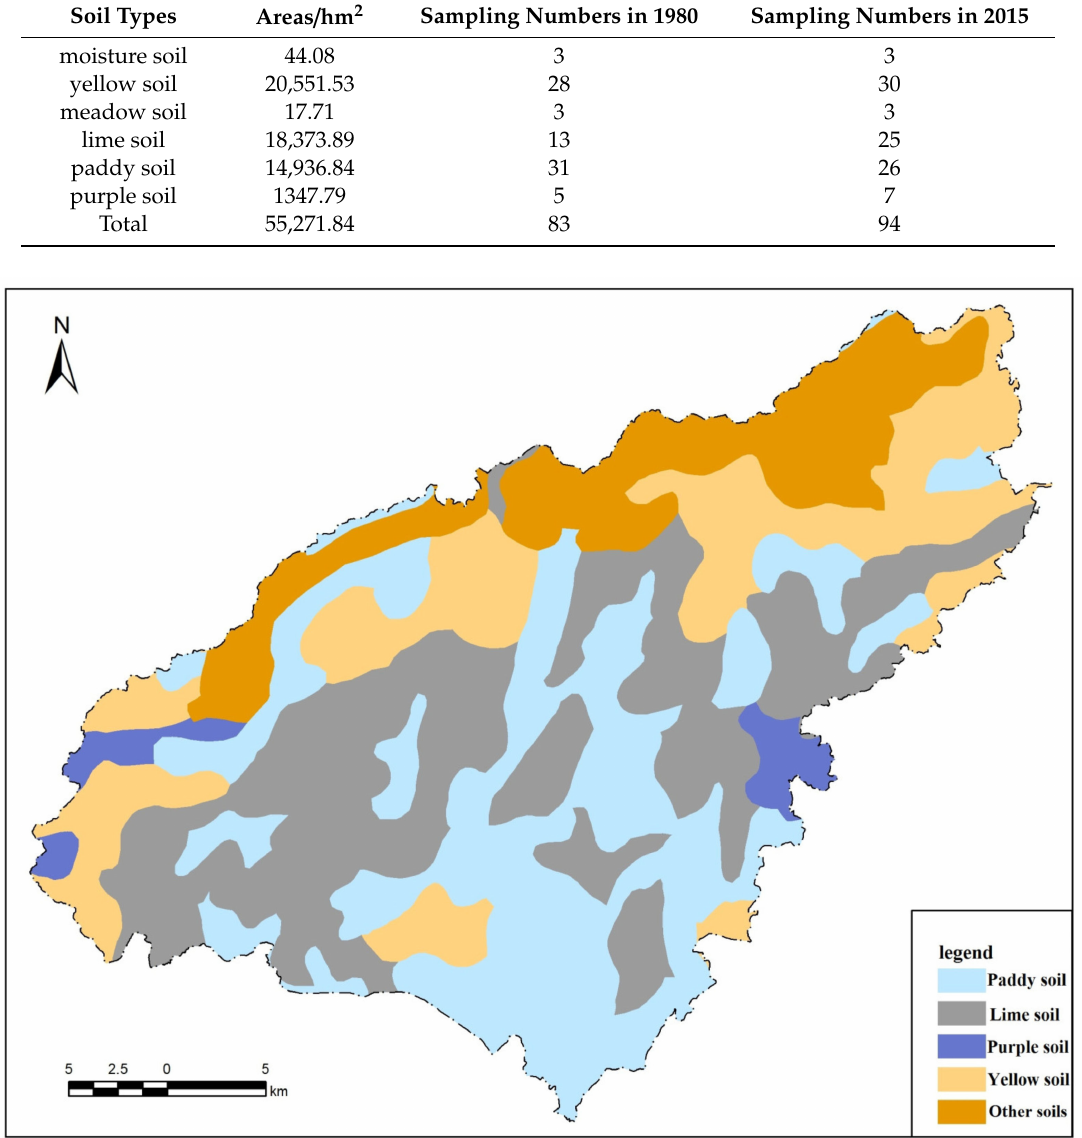
Figure 1. Distribution map of di ff erent soil types of study